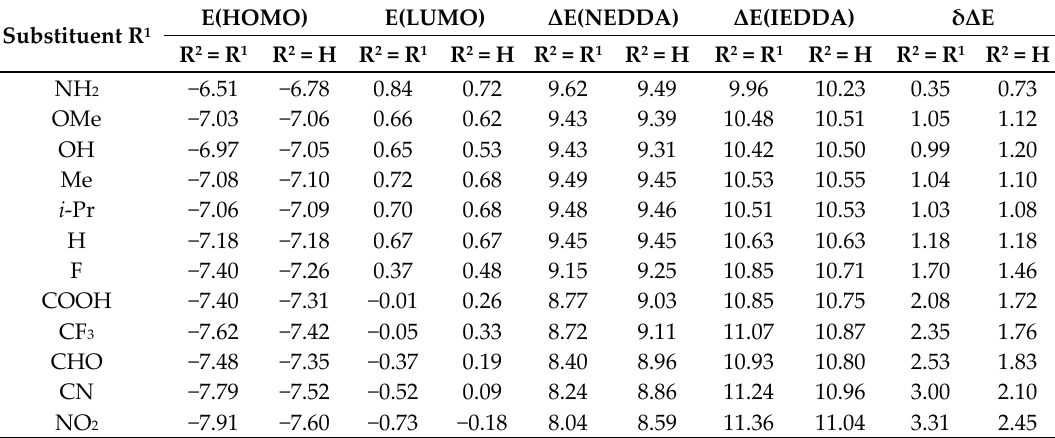
Table 1. HOMO and LUMO energies (in eV) of the di-substituted (R 1 = R 2 ) and mono-substituted (R 2 = H) fragment 2 , and HOMO-LUMO gaps (in eV) for the NEDDA and IEDDA reactions with 1,3-butadiene. Δ E(NEDDA) = E(LUMO dienophile) − E(HOMO diene) and Δ E(IEDDA) = E(LUMO diene) − E(HOMO dienophile). Also, δΔ E = Δ E(IEDDA) − Δ E(NEDDA). Results for reaction with the non-substituted fragment (row for H in the middle of the Table) are included for comparison. Substituent R 1